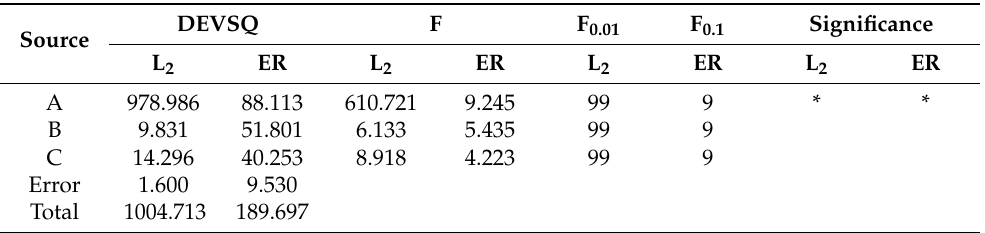
Table 2. The results of